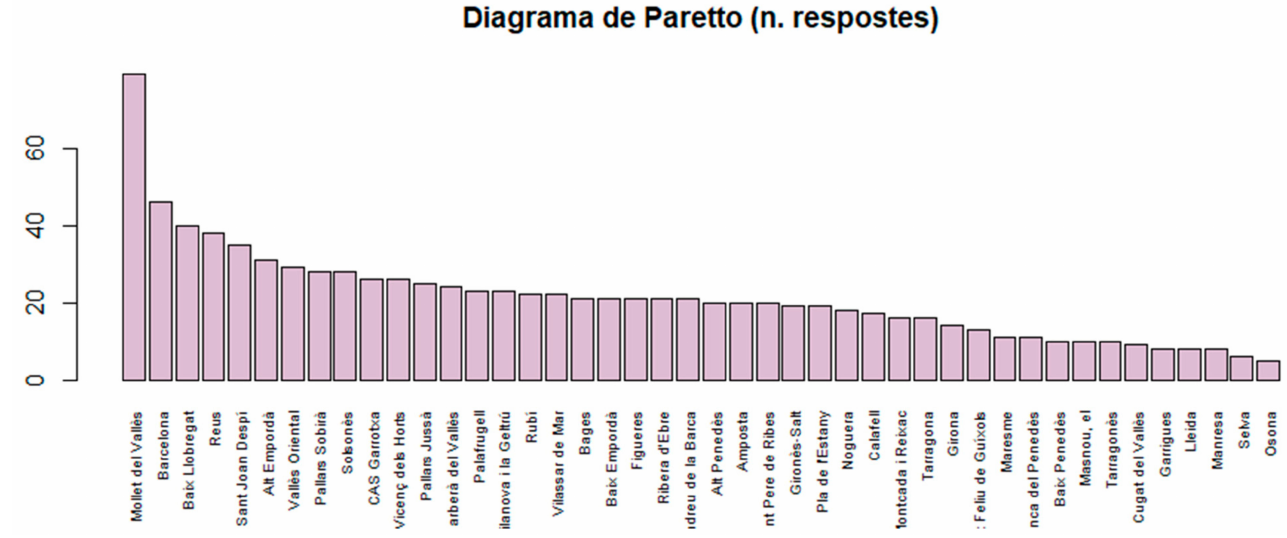
Figure 18. Number of answers per BASS.